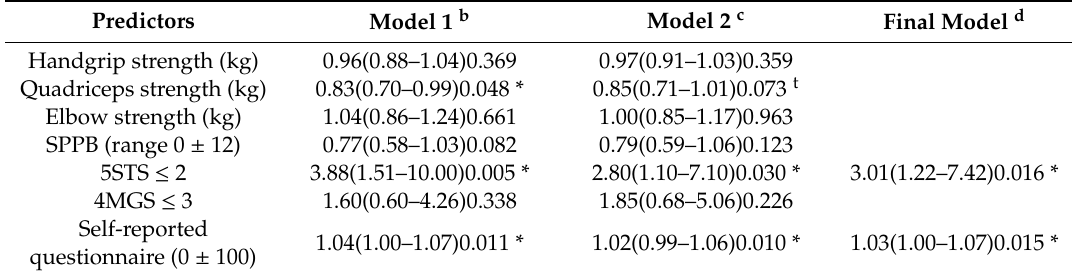
Table 3. Multivariate regression models show the predictive strengths of non-pulmonary factors for poor 6MWT performance ( < 350 m) a .